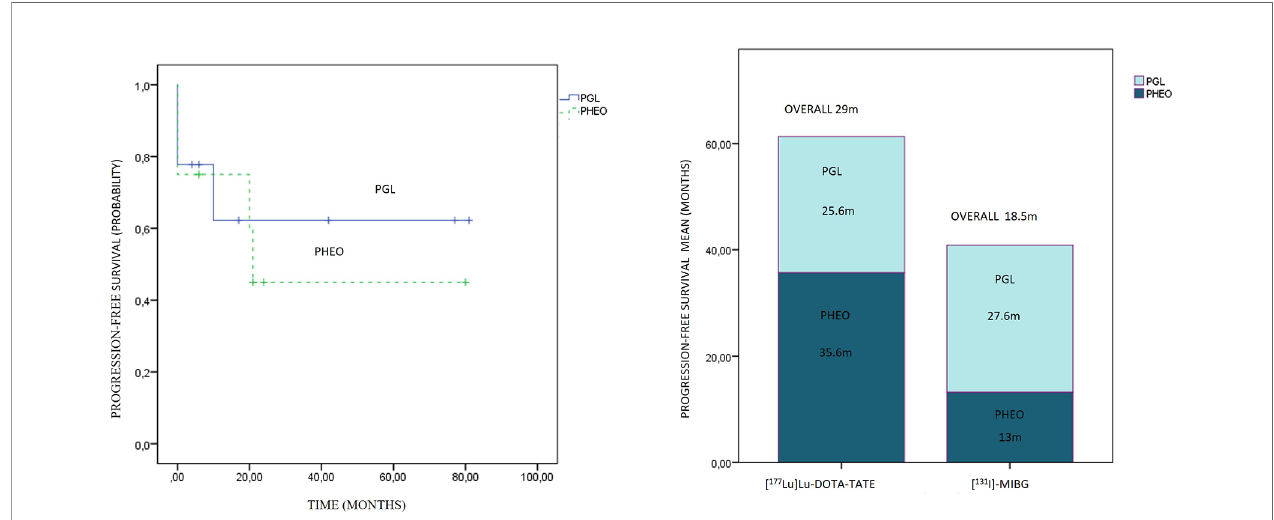
FIGURE 7 | On the left side, progression-free survival Kaplan – Meier plot related to paragangliomas and pheochromocytomas is presented. On the right side, the progression-free survival distribution according to treatment and primary location is